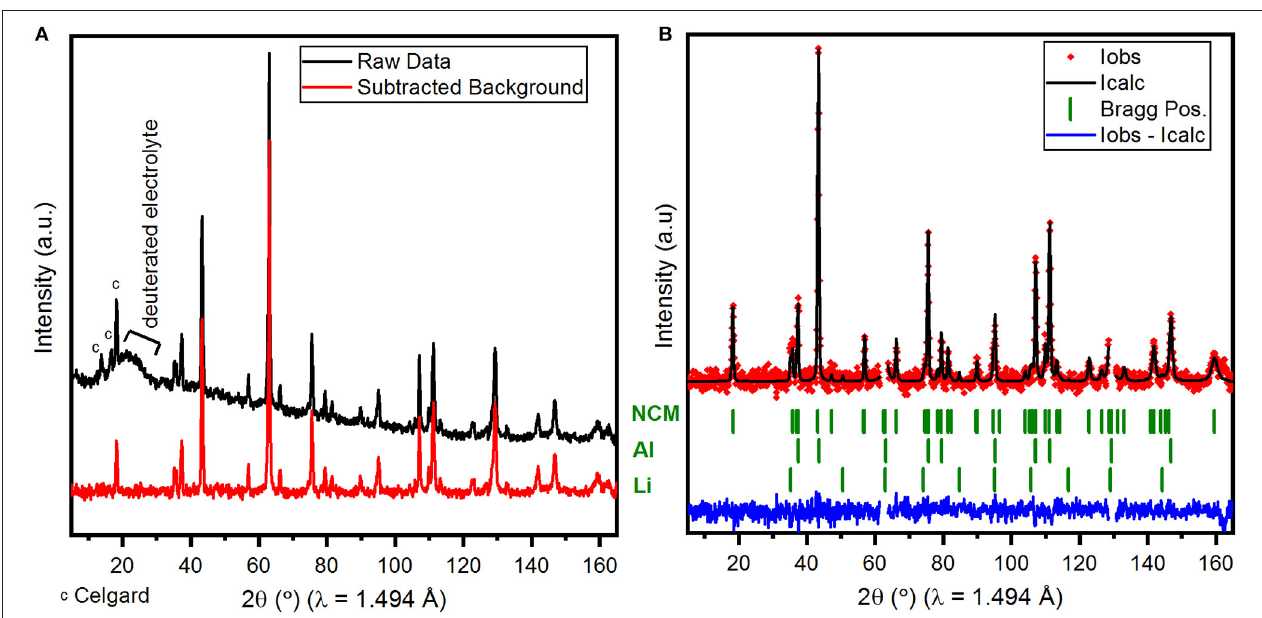
FIGURE 5 | (A) Comparison of a neutron diffraction pattern as collected during the operando experiments (ca. 3.7V vs. Li + /Li during charge) (black) and after subtraction of the background contributions of the Celgard and deuterated electrolyte (red). (B) Rietveld refinement profile based on this background-subtracted diffraction